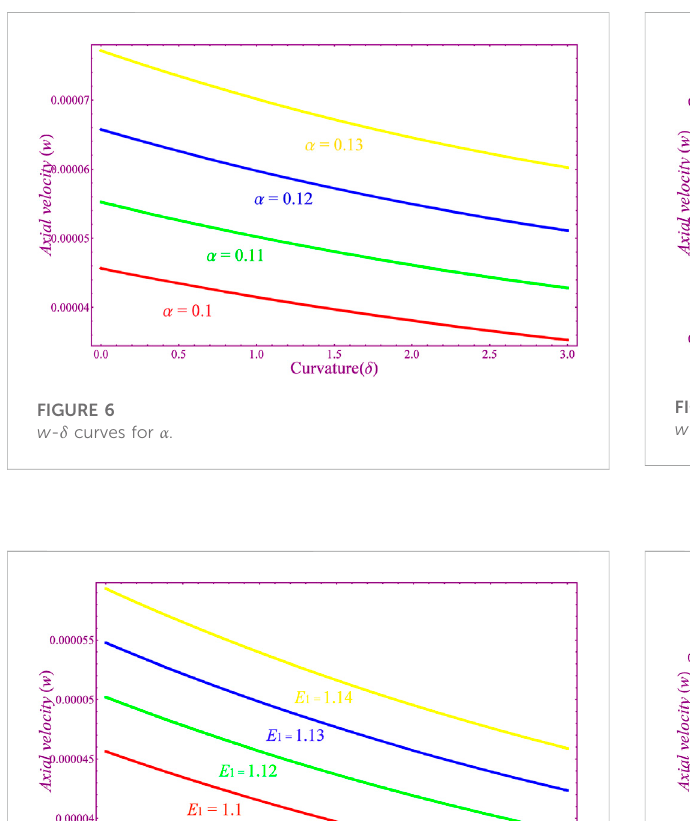
FIGURE 7 w - δ curves for E